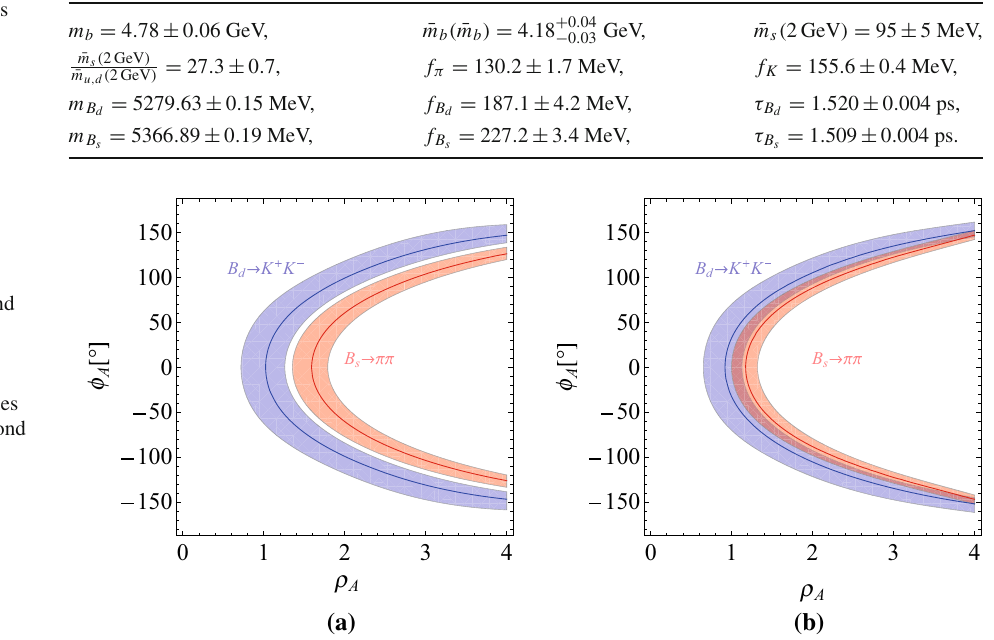
Table 2 The CP -averaged branching ratios in the unit of 10 − 7 , where the theoretical uncertainties are from the input parameters listed in Table 1. Different scenarios are explained in the text Decay mode Our results Ref.